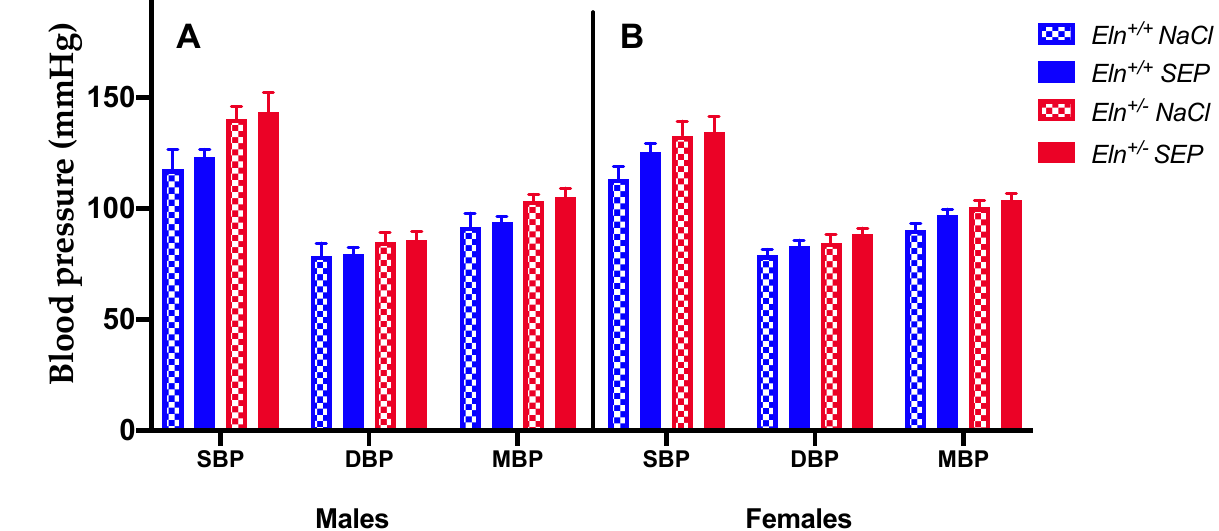
Figure 1. Systolic, diastolic and mean arterial blood pressures. The measurements were performed 3 days after NaCl (control) or SEP intravenous injection in the caudal vein of male and female mice of Eln +/+ or Eln +/- genotypes. ( A ) Males, ( B ) Females, SBP: Systolic Blood Pressure, DBP: Diastolic Blood Pressure, MBP: Mean Blood Pressure. No significant effect of SEP treatment could be detected (four ‐ way ANOVA and three ‐ way ANOVAs for each sex, p > 0.05). Control animals were injected with the same volume of 0.9% NaCl. Values are mean ± SEM. n = 4–7 per group.